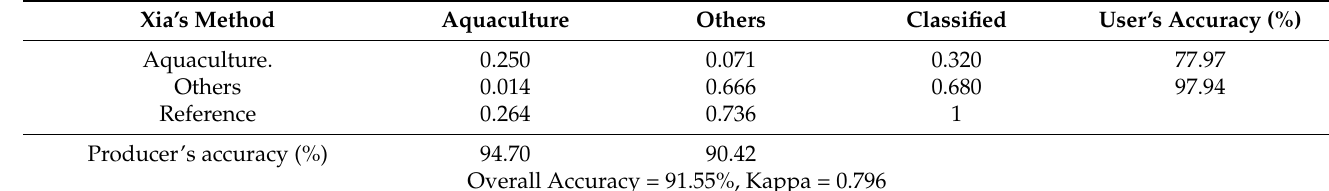
Table 6. Confusion matrix of Xia’s method in typical sites